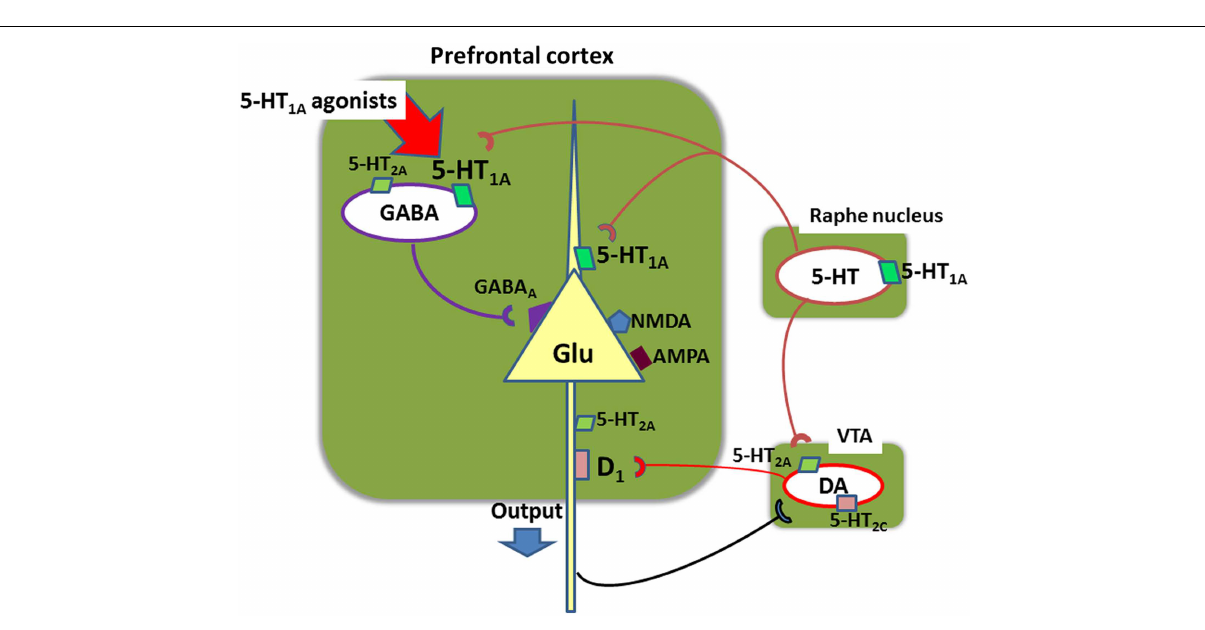
FIGURE 7 | Neural network in the prefrontal cortex involving glutamate (Glu), gamma-aminobutyric acid (GABA), serotonin (5-HT), and dopamine (DA) neurons . Systemic administration of 5-HT 1A agonists, such as 8-OH-DPAT, inhibits action potentials of GABA neurons, leading to disinhibition of glutamate neurons (Llado-Pelfort et al., 2011; Sumiyoshi and Higuchi, 2013).This also leads to activation of meso-cortical dopamine neurons. For example, administration of